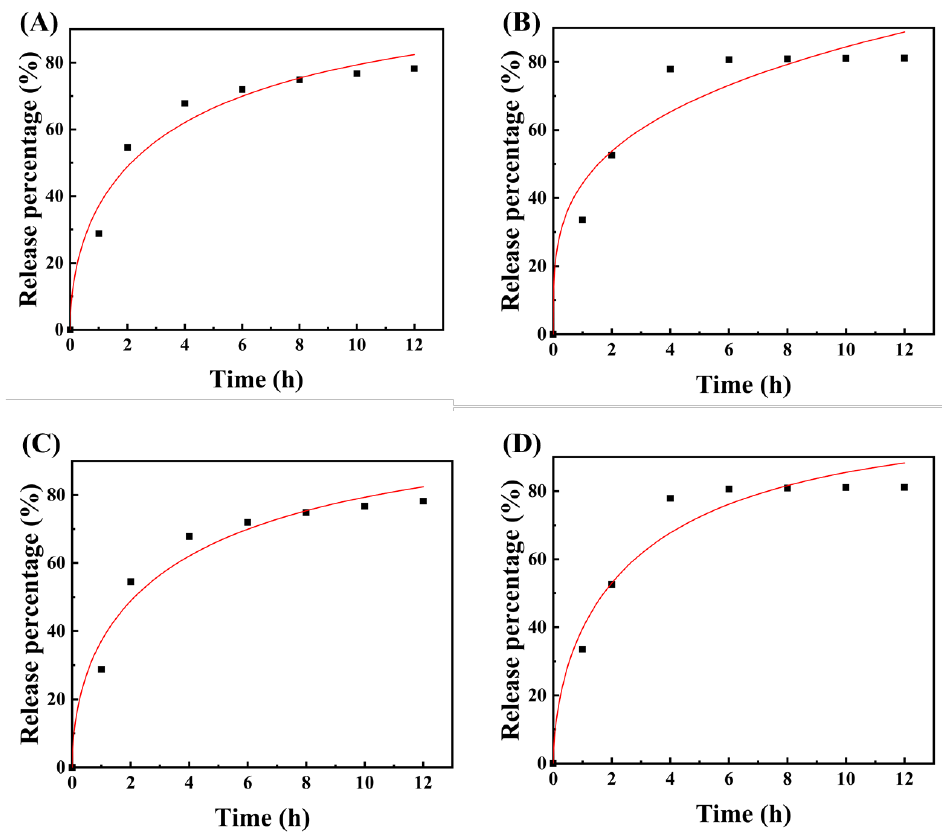
Figure 6. The drug release curves of R1 and R3 dosage forms were fitted by Korsmeyer-Peppas ( A , B ) and Weibull ( C , D ) models, respectively.